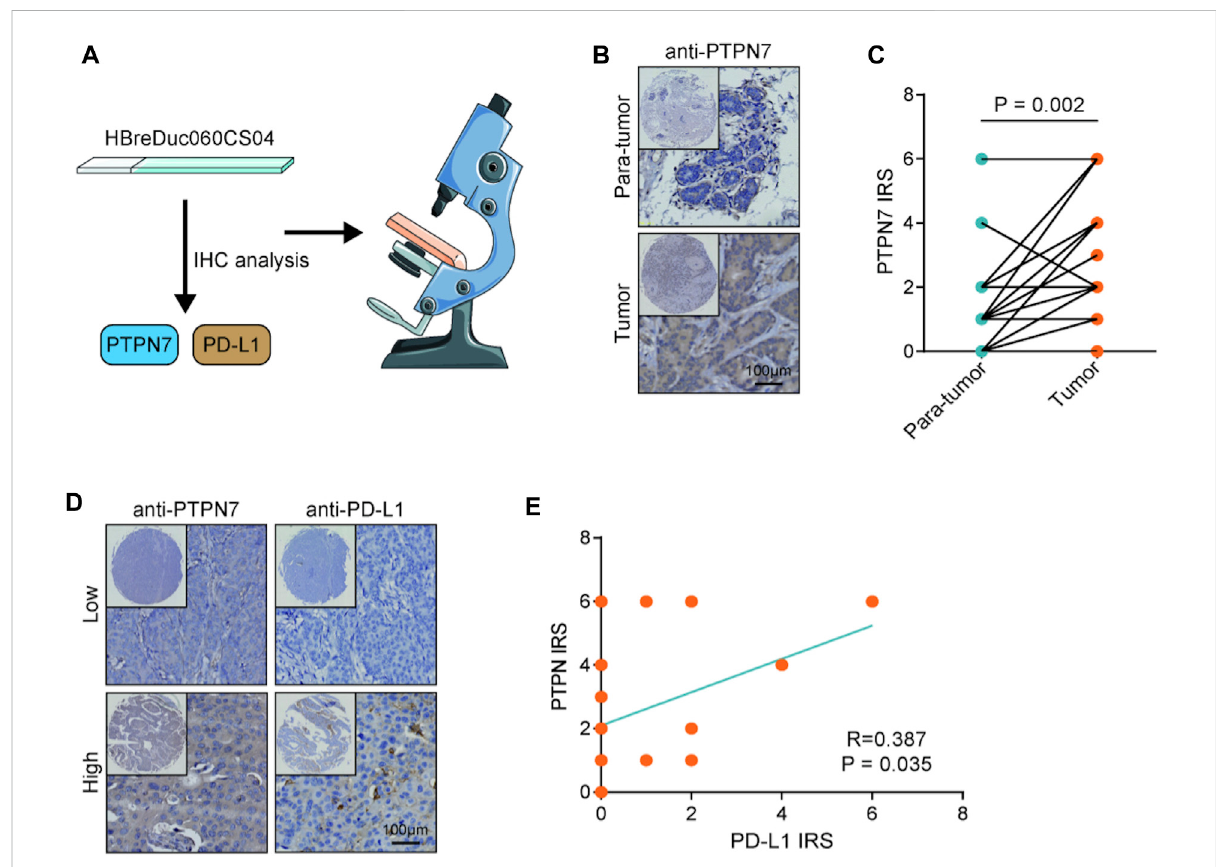
FIGURE 5 Validation of PTPN7 expression in BrCa and its correlation with PD-L1. (A) Using the TMA which contained PTPN7 & PD-L1 and acquiring the tissue images. (B) Representative images revealing PTPN7 expression in tumor and para-tumor tissues. Magni fi cation, 200×. (C) Expression levels of PTPN7 in tumor and para-tumor tissues. (D) Representative images revealing PD-L1 expression in the high and low PTPN7 groups. Magni fi cation, 200× (E) Correlation between PTPN7 and PD-L1